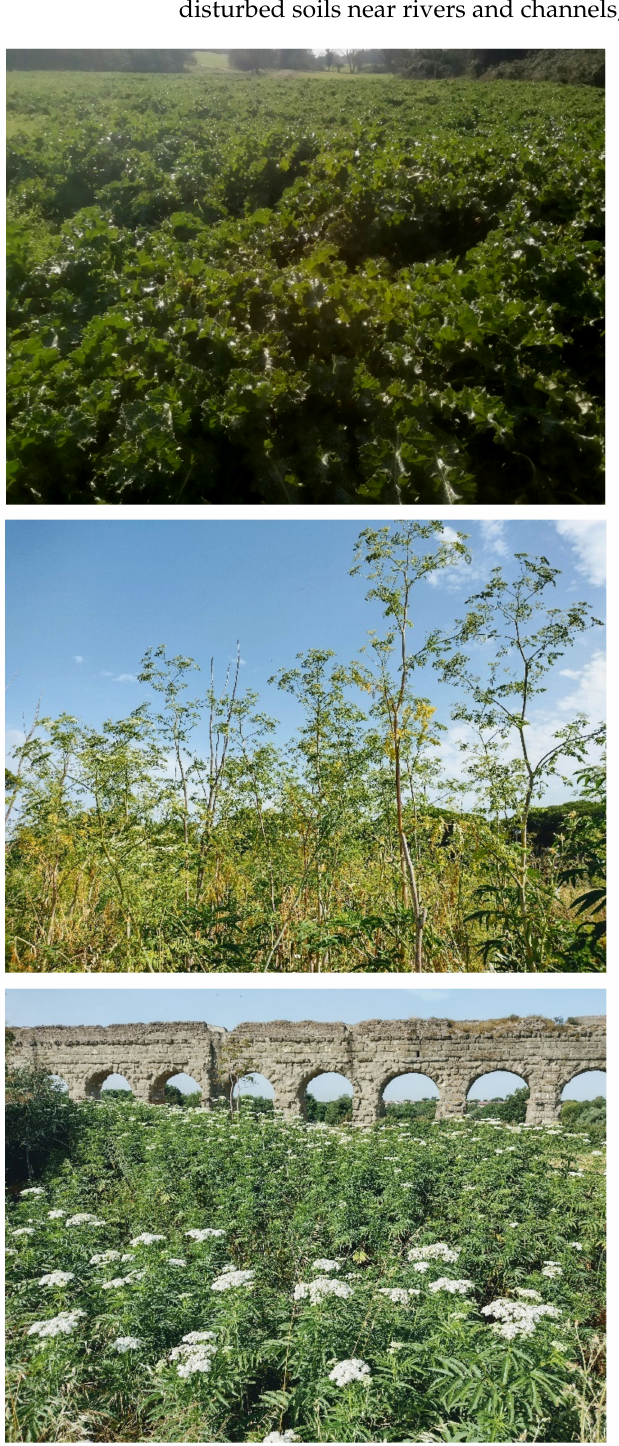
Figure 32. Artemisietea vulgaris: Silybum marianum community, Caffarella valley (top photo); Conium maculatum community, Acquedotti locality (central photo); Sambucus ebulus community, Acquedotti locality (bottom